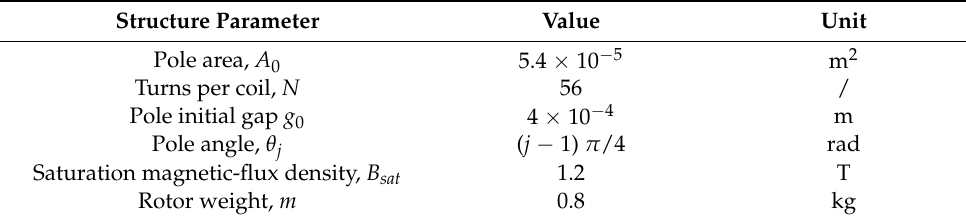
Figure 6. Structural of an eight-pole symmetrical radial magnetic bearing. Table 1. Units for Magnetic Properties.